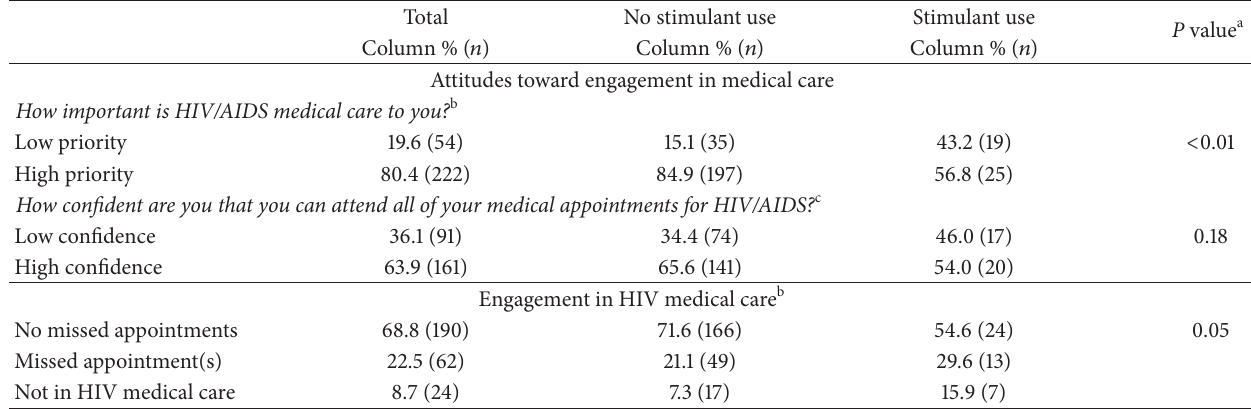
Table 2: Engagement in HIV care and attitudes toward HIV care among stimulant and nonstimulant-using men who have sex with men. Total No stimulant